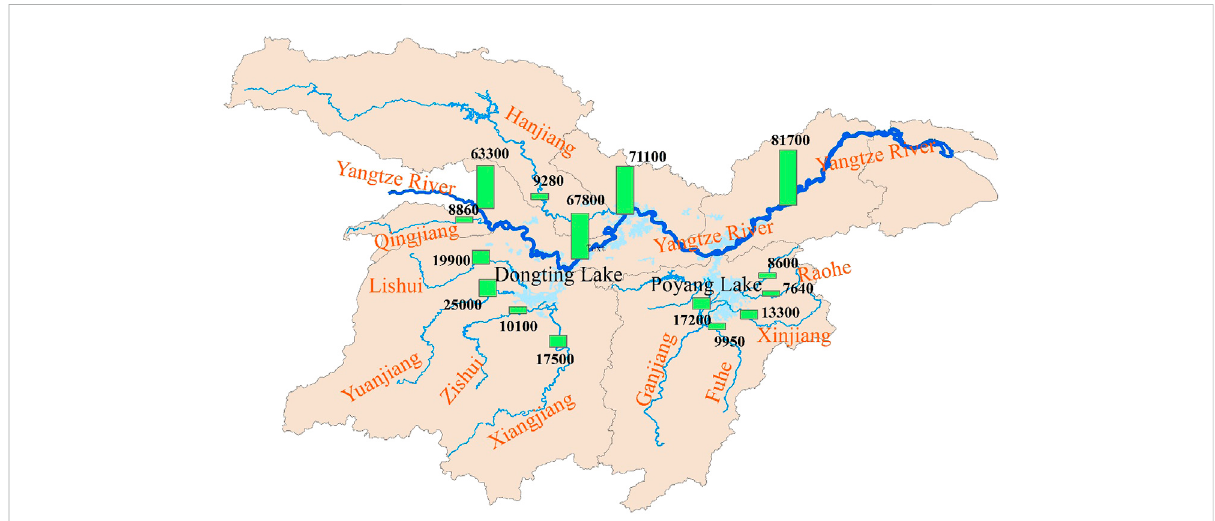
FIGURE 4 Maximum discharge on the middle Changjiang and large tributaries during the 1998 fl